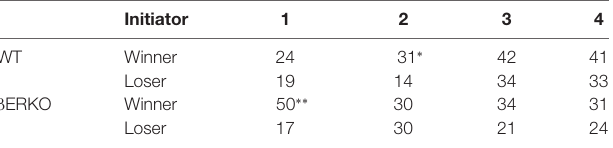
TABLE 4 | Total number of dyad transitions ended by subordinate behaviors